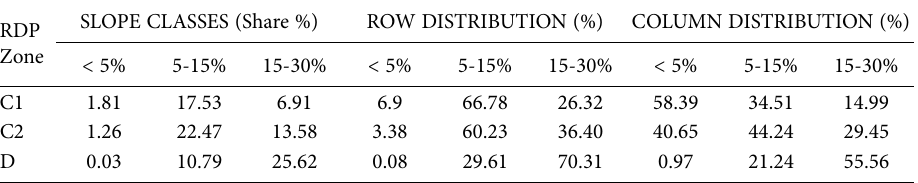
Table 8. Mugello - Distribution of farmland surfaces (%) in RDP zones according to the slope classes.